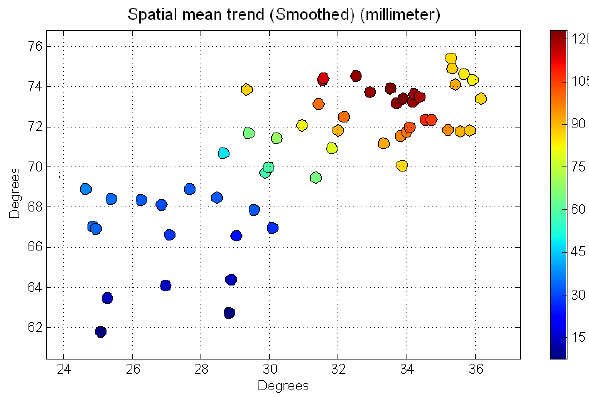
Fig. 1. The map of smoothed mean trend aggregated over time.